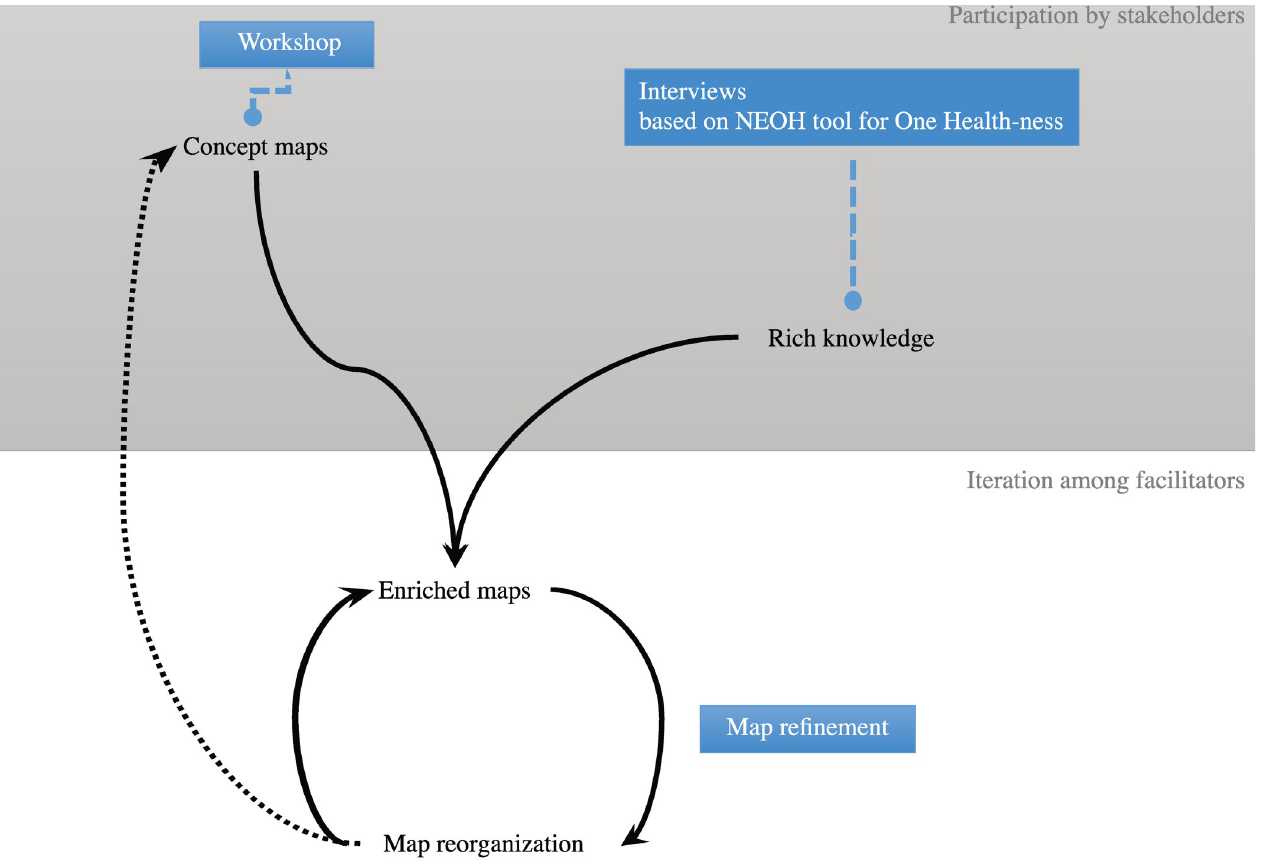
Fig 1. Schematic presentation of the iterative process of the map refinement.